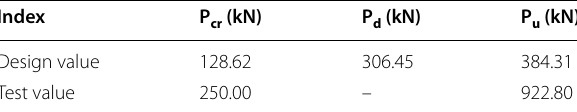
Table 7 Comparison of design-test data